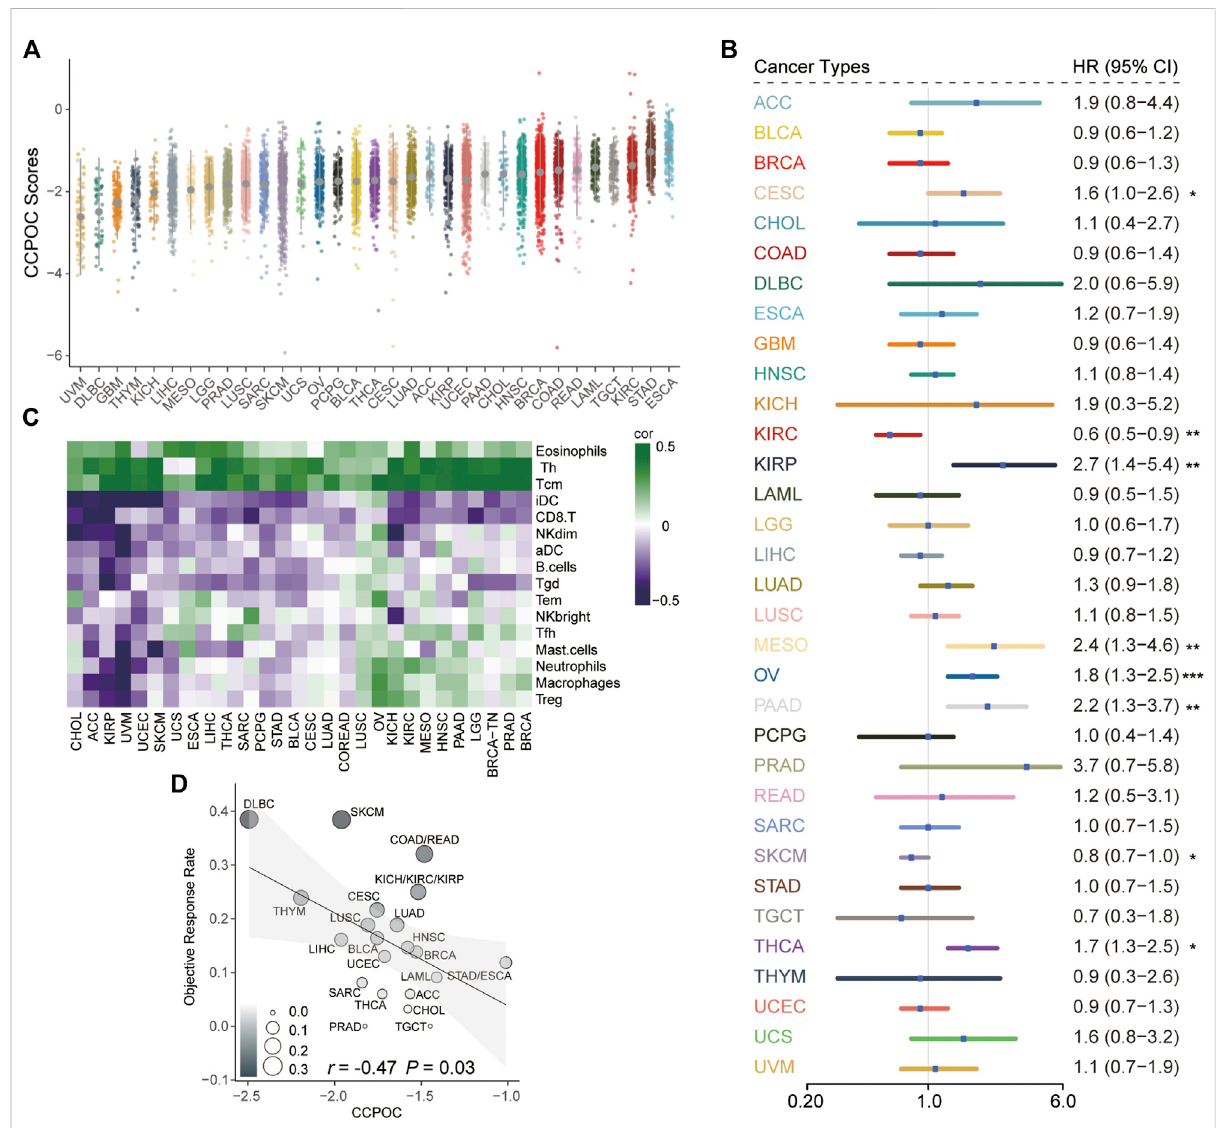
FIGURE 7 Pan-canceranalysisoftheprognosticsigni fi canceandanti-PD-1/PD-L1responseforCCPOC. (A) DistributionofCCPOCscoresinpan-cancer. (B) Prognostic relevance of CCPOC in various cancer types. (C) Heatmap of the correlation of immune cells and CCPOC scores across various cancer types. (D) Correlation between CCPOC and anti-PD-1/PD-L1 ORR of various cancer types. (* p < 0.05, ** p < 0.01, and *** p <